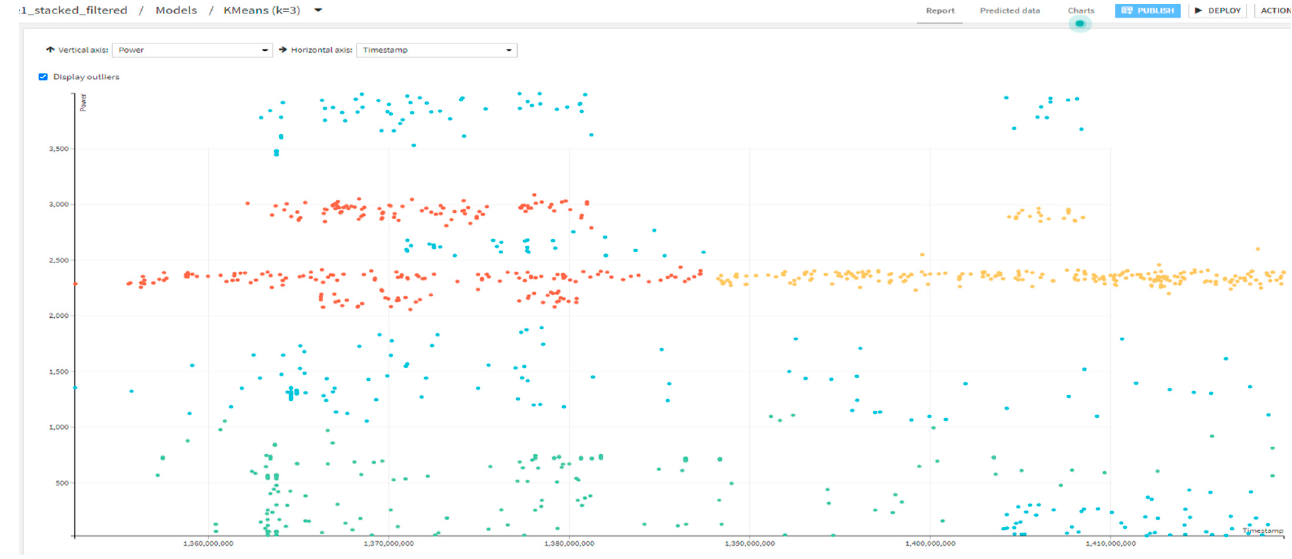
Figure 8. Post ‐ clustering chart. Figure 8. Post-clustering